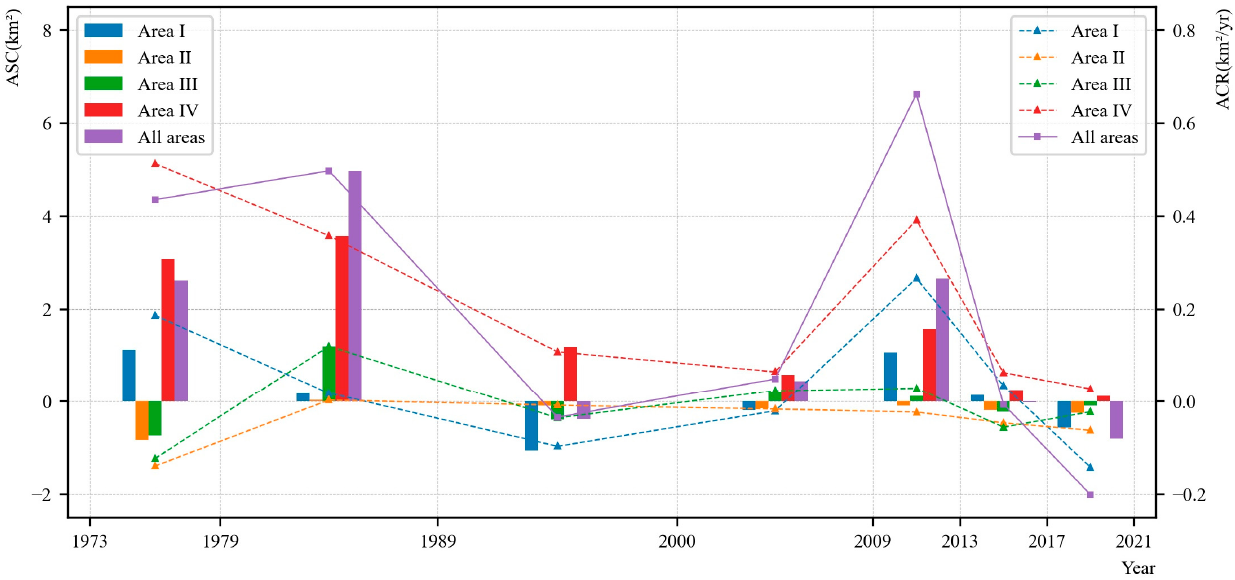
Figure 8. The Area of Shoreline Change (ASC) and Area Change Rate (ACR) for Area I, Area II, Area III, Area IV, and the whole region.